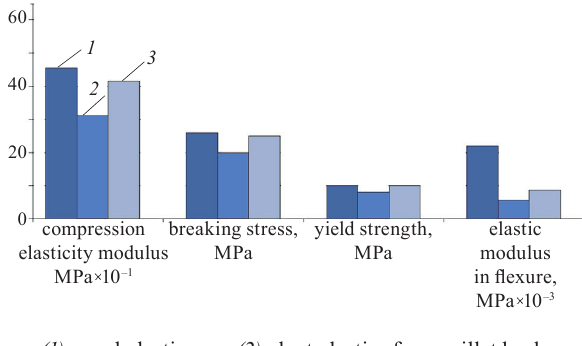
Figure 4 Wood plastic fragment with signs of splitting, swelling, marginal and longitudinal fragmentation